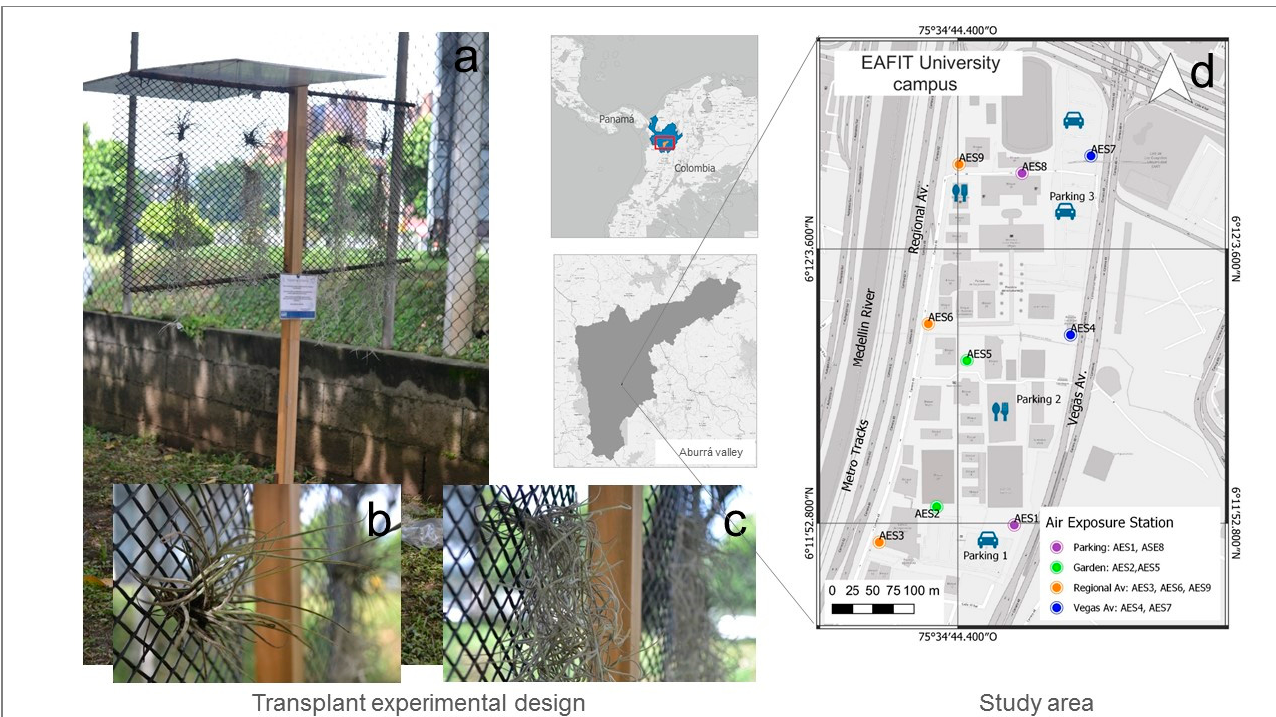
Figure 1. Experimental design: ( a ) air exposure station (AES); ( b ) Tillandsia recurvata ; ( c ) Tillandsia usneoides . ( d ) Study area.